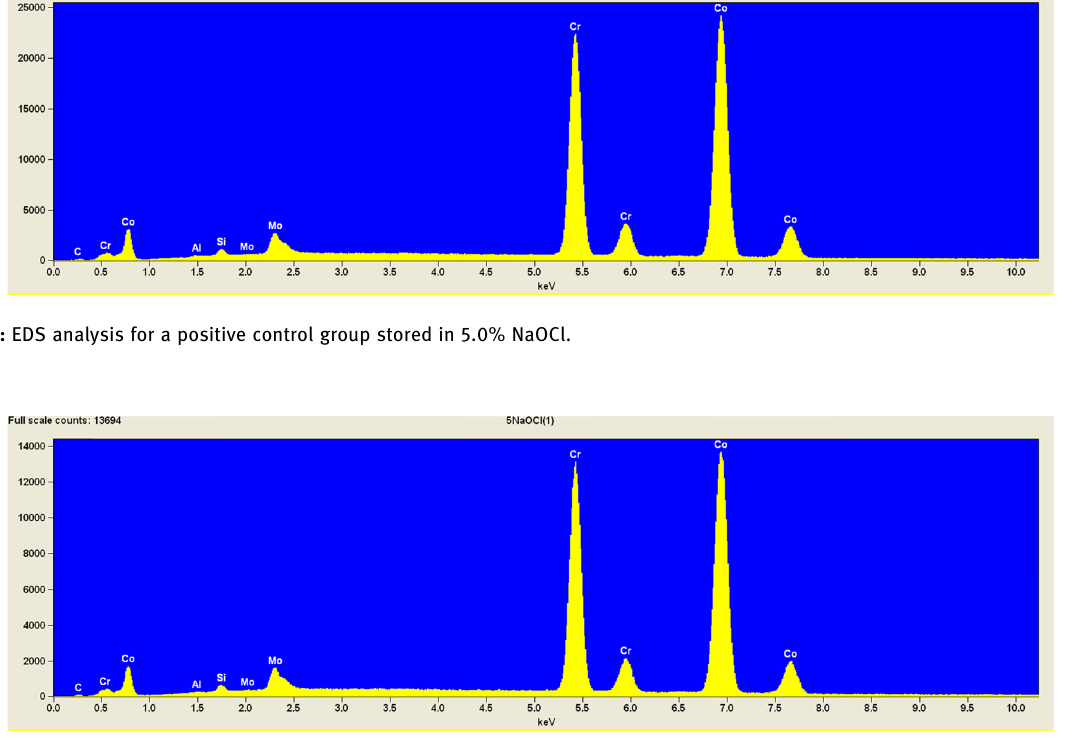
Figure 3: EDS analysis for the samples stored in 0.5%